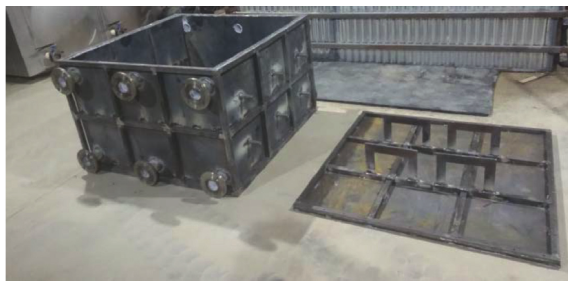
Figure 10: Physical drawing of